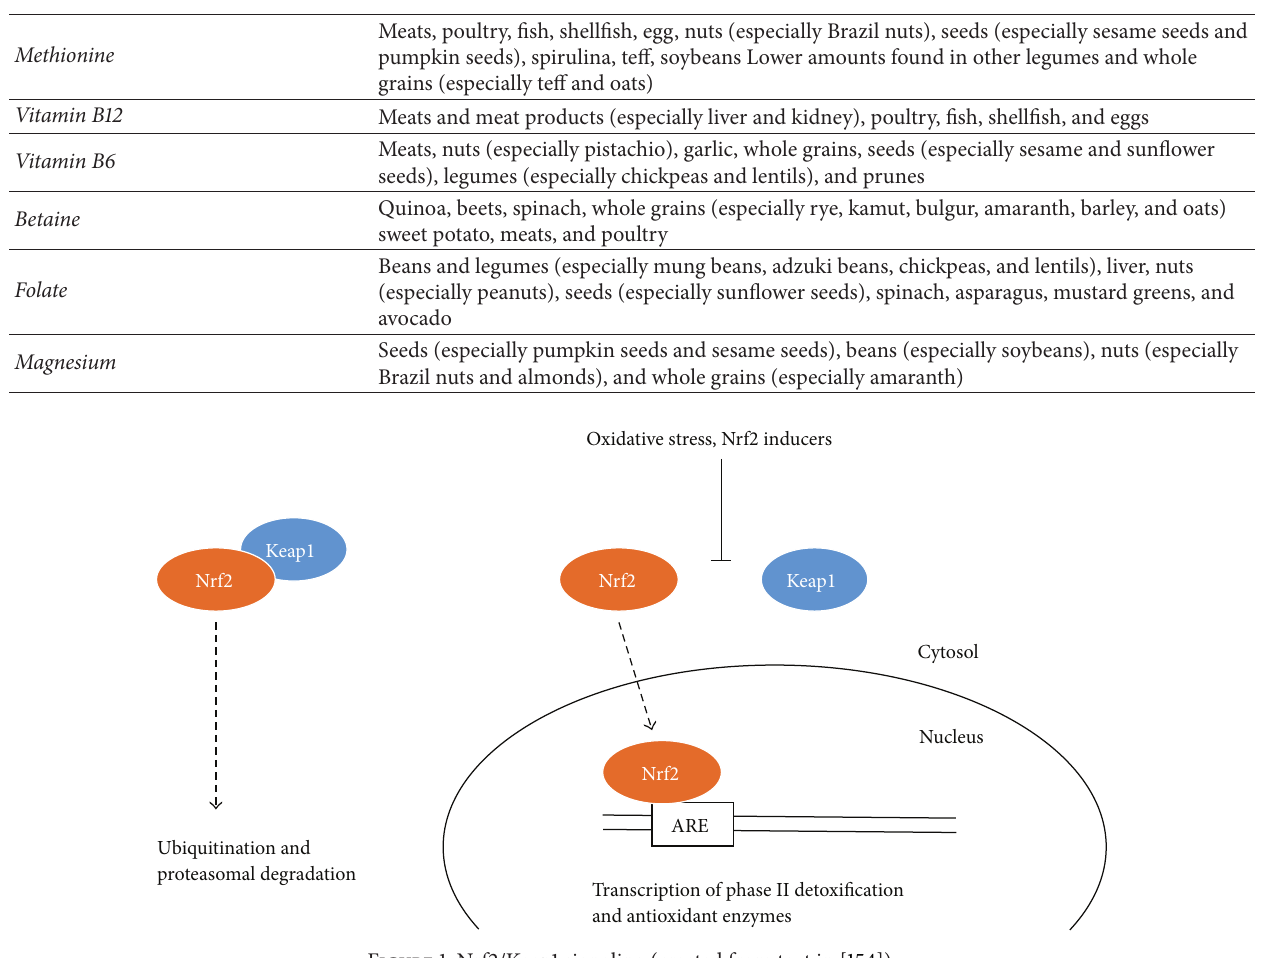
Figure 1: Nrf2/Keap1 signaling (created from text in